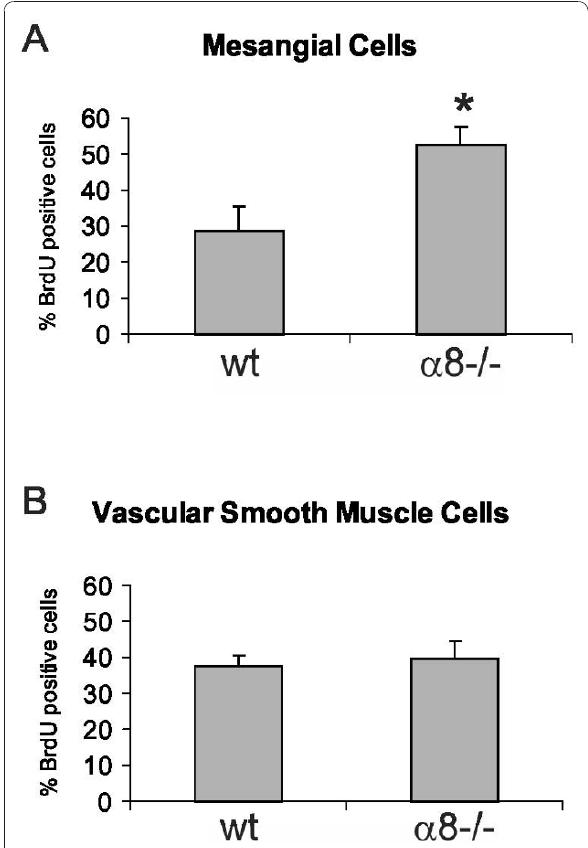
Figure 10 Cell proliferation of wild type (wt) and a 8 integrin- deficient ( a 8-/-) mesangial cells (A) and vascular smooth muscle cells (B) in response to stimulation with 10% FCS . Results are representative for at least 3 similar experiments. Data are means ± sd. * p < 0.05 vs.